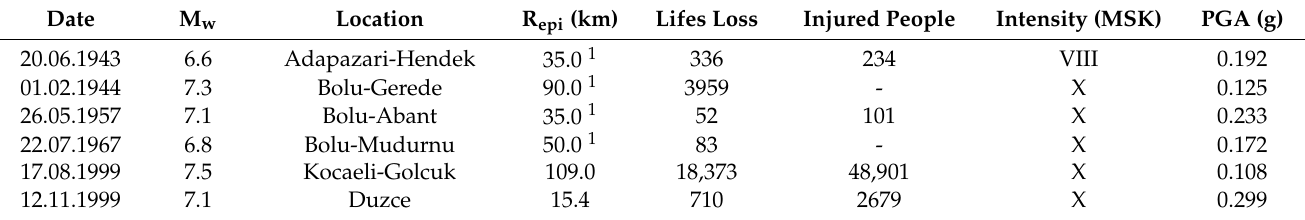
Table 3. Major recorded seismic events close to the case study